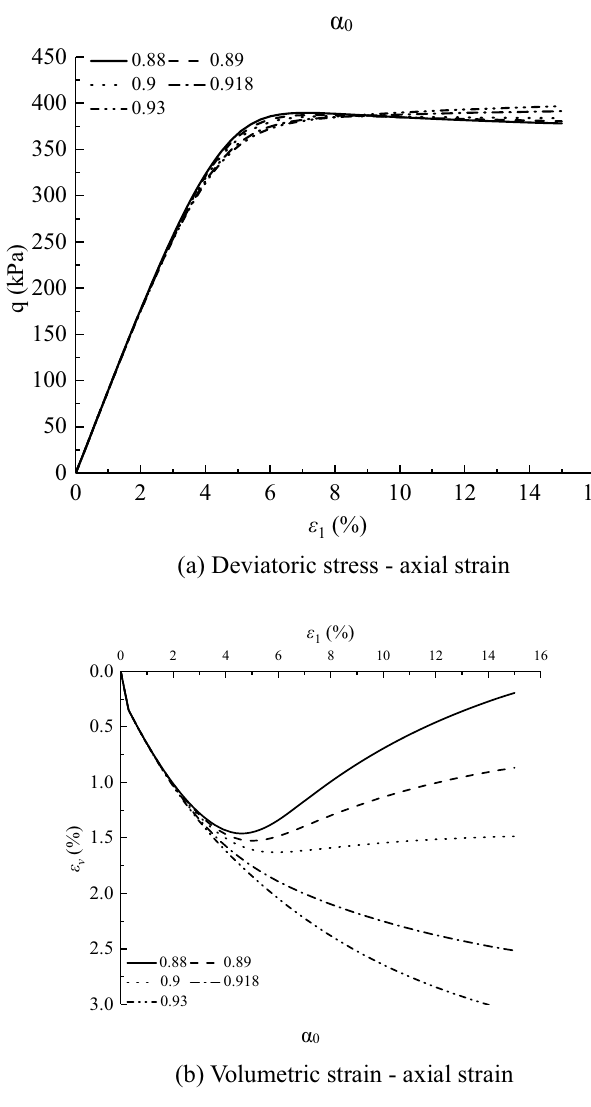
Figure 11. Sensitivity analysis of simulation results with varying α 0